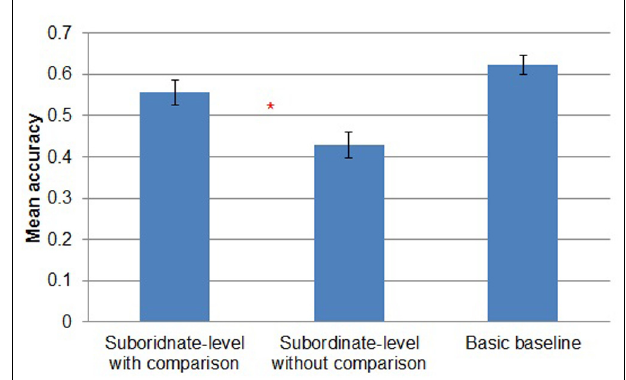
FIGURE 3 | Mean accuracy by study condition in Experiment 1. Error bars represent SEs. * p < 0.05.